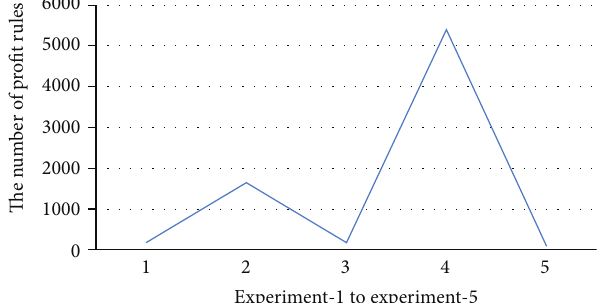
Figure 10: The numbers of profit-rules from five different price distributions.